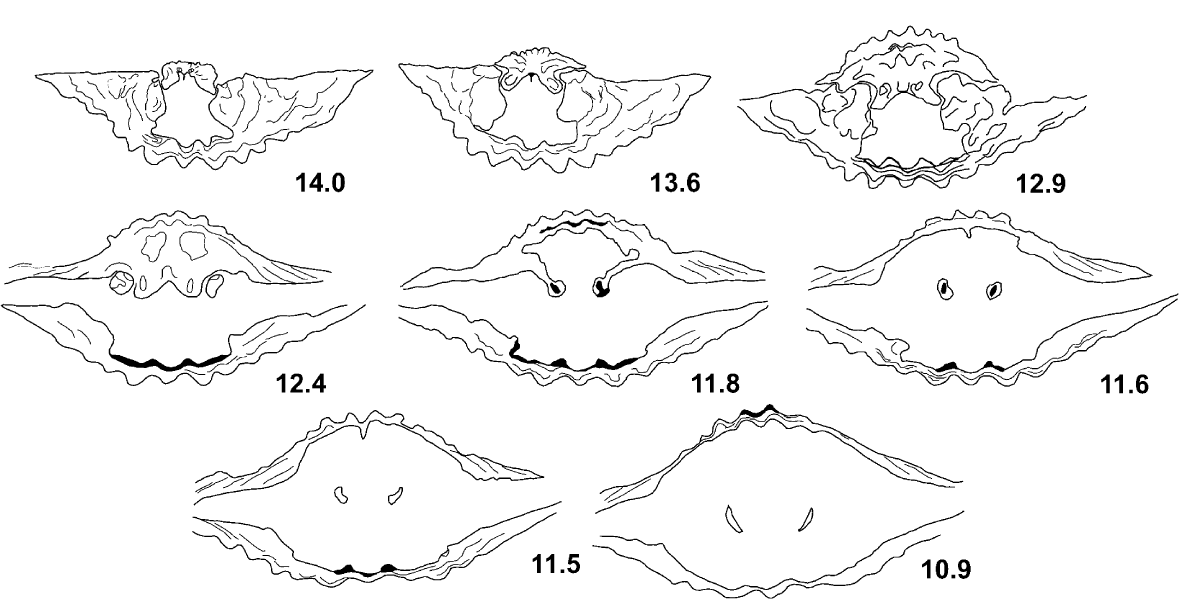
Fig. 10. Transverse serial sections of Stegocornu denisae sp. nov.; Llandovery, mid-late Aeronian, Shabdjereh Formation, loose sample, vicinity of Shabdjereh; CNIGR 12600/126 (L > 14.0, W = 22.5, T = 10.5). Due to damaged ventral beak, numbers indicate distances (mm) from the anterior margin of the